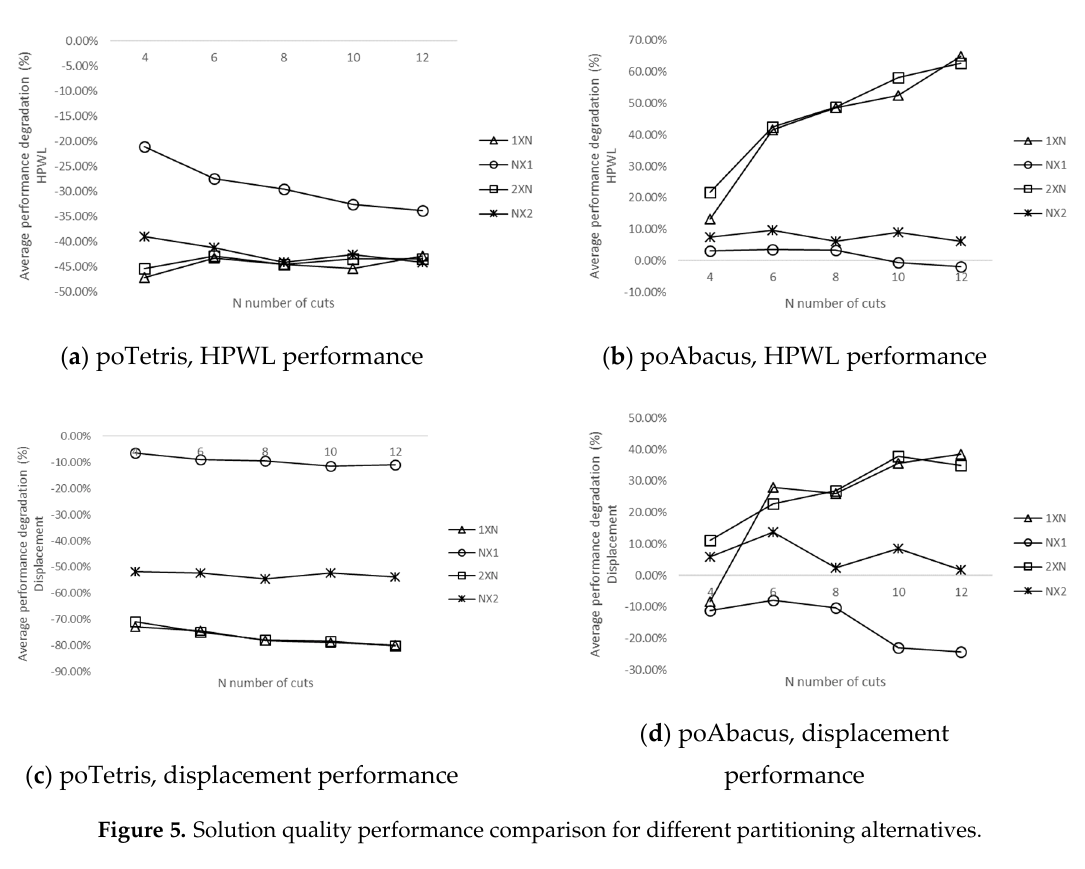
Figure 5. Solution quality performance comparison for different partitioning alternatives.